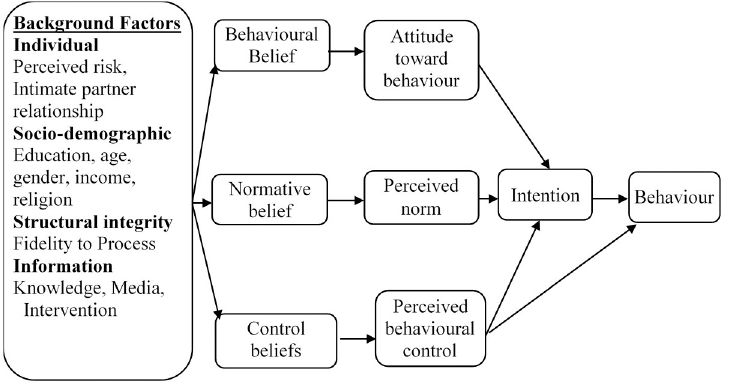
Fig 3. Theory of planned behaviour